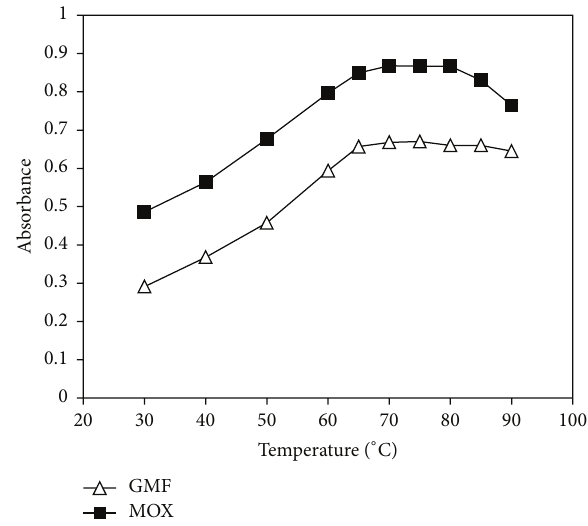
Figure 4: Effect of temperature on the formation of colored product drug-NBD-Cl, (GMF) = 8.0 𝜇 gmL −1 + 1.0 mL NBD-Cl (5.0 × 10 −3 M) for 20 min and (MOX) = 12 𝜇 gmL −1 + 0.8mL NBD-Cl (5.0 × 10 −3 M) for 15